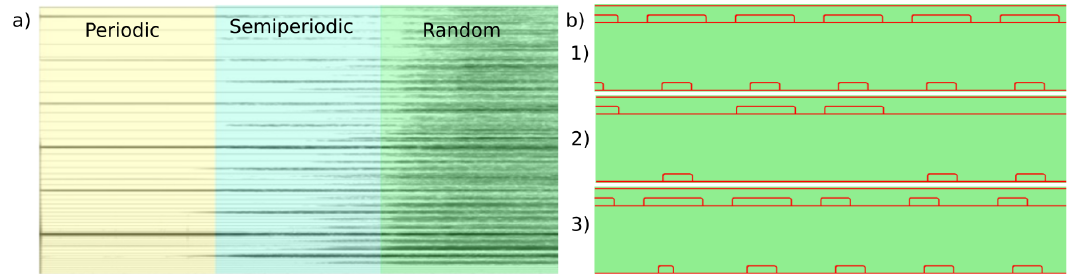
Figure 8. ( a ) schematic illustration of semiperiodicity; ( b ) geometry of a periodic (1) , a Thue–Morse semiperiodic (2) and an optimized semiperiodic double grating